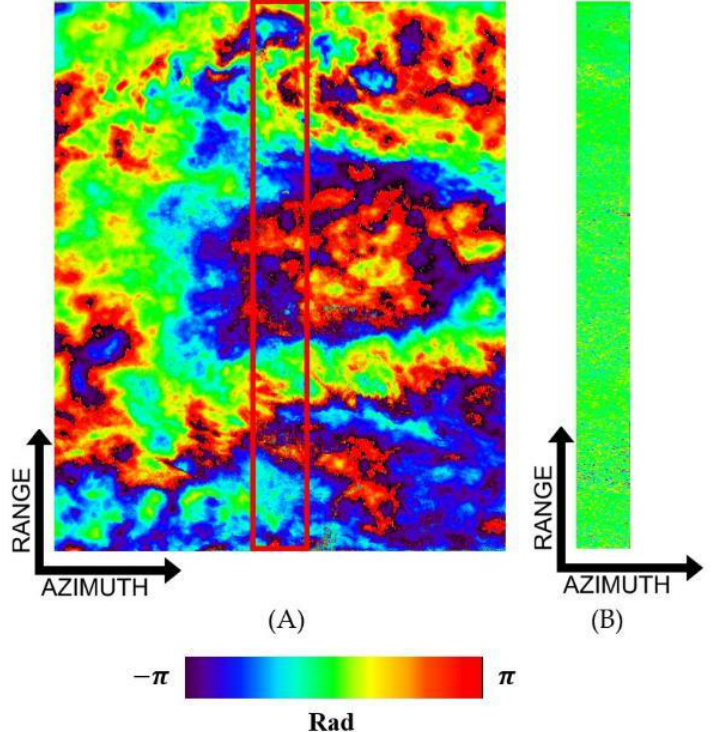
Figure 20. ( A ) Two-burst interferogram (stationary case) related to the Sentinel-1 SAR data pairs (11–23 May 2019) of the Ridgecrest area and ( B ) phase di ff erence between the two contiguous bursts in the overlapped region, highlighted with a red rectangle, before ESD application.